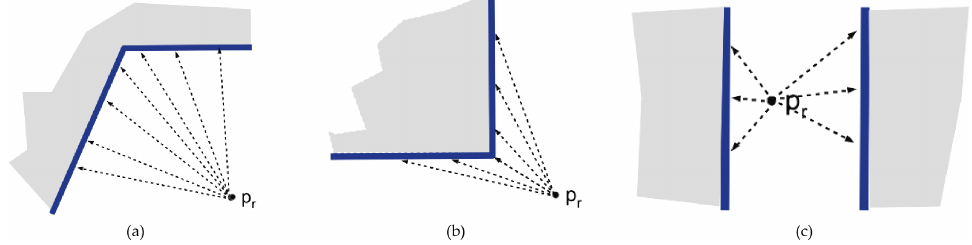
Figure 11. The user is located in p r close to a couple of walls: ( a ) inner corner, ( b ) outer corner and ( c ) parallel walls.